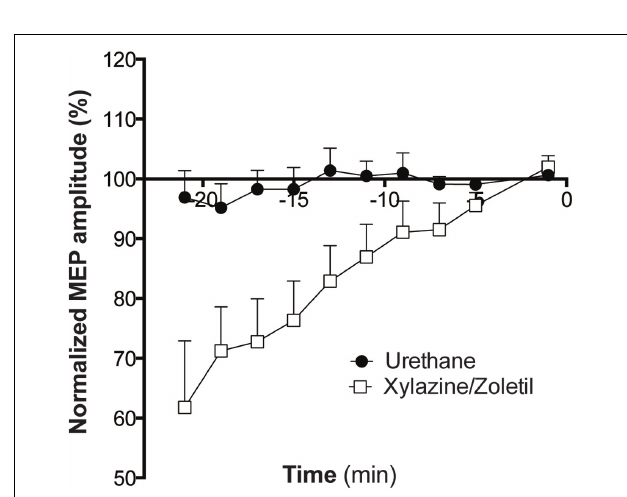
FIGURE 3 | The effect of anesthetic on MEP amplitude during the baseline period. MEPs recorded from all animals anesthetized with xylazine/zoletil ( n = 9), showed increased amplitudes over the baseline recording period, however, those from urethane anesthetized animals ( n = 9) remained stable. Data shown are mean ± SEM. Normalized amplitudes from each minute are grouped into 2-min